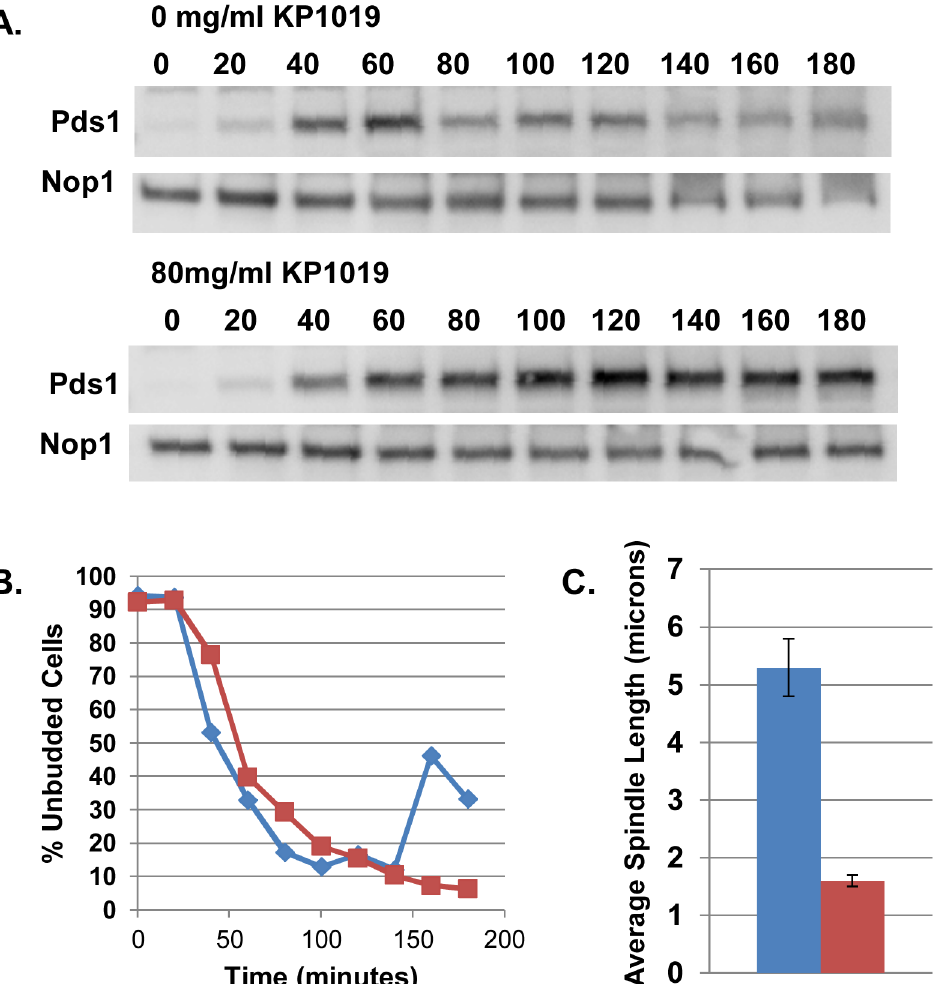
Fig 4. KP1019 induces a pre-anaphase cell cycle delay. A and B. Cells arrested in the G1 phase of the cell cycle by mating pheromone were released in the absence (0 mg/mL KP1019) and presence (80 mg/mL KP1019) of drug. Pds1-myc (A) and budding index (B) were measured every 20 minutes after release from G1. A. Pds1-myc epitope tagged protein expression levels assayed as cells progress through the cell division cycle. Antibody against the Nop1 protein is used as loading control. Normalized Pds1 band intensities are represented below each blot. B. Budding index (% of unbudded cells in the population) of cells used to measure Pds1 levels as cells progress through the cell division cycle. C. Distance between SPB in large budded cells that are untreated (blue bar) or treated with 80 mg/mL KP1019 for three hours (red bar) were determined as described in Materials and Methods. The average of three replicates is presented with 2XSE error